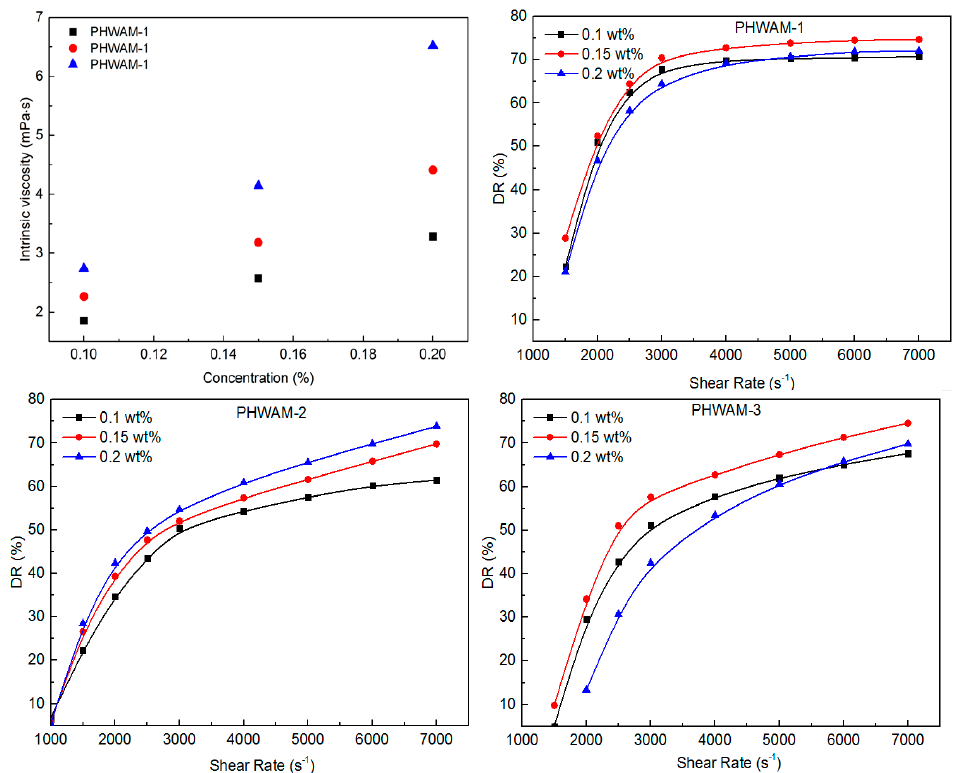
Figure 4. Viscosity and DR properties of drag reducers with different concentrations in fresh water.